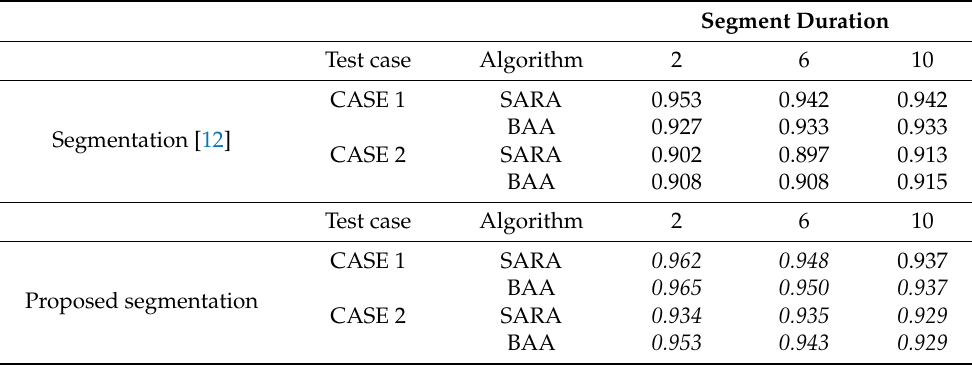
Table 8. SSIM values obtained using the SARA and BBA adaptive streaming algorithms, two network test cases while BBB was segmented using the segmentation available in [12] and the proposed